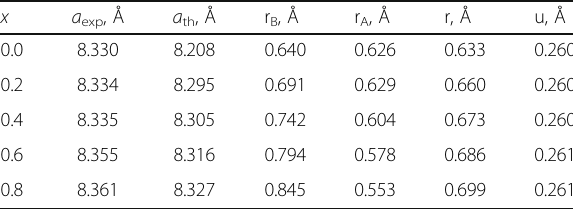
Table 2 Values of ionic radii and theoretical value of lattice constant